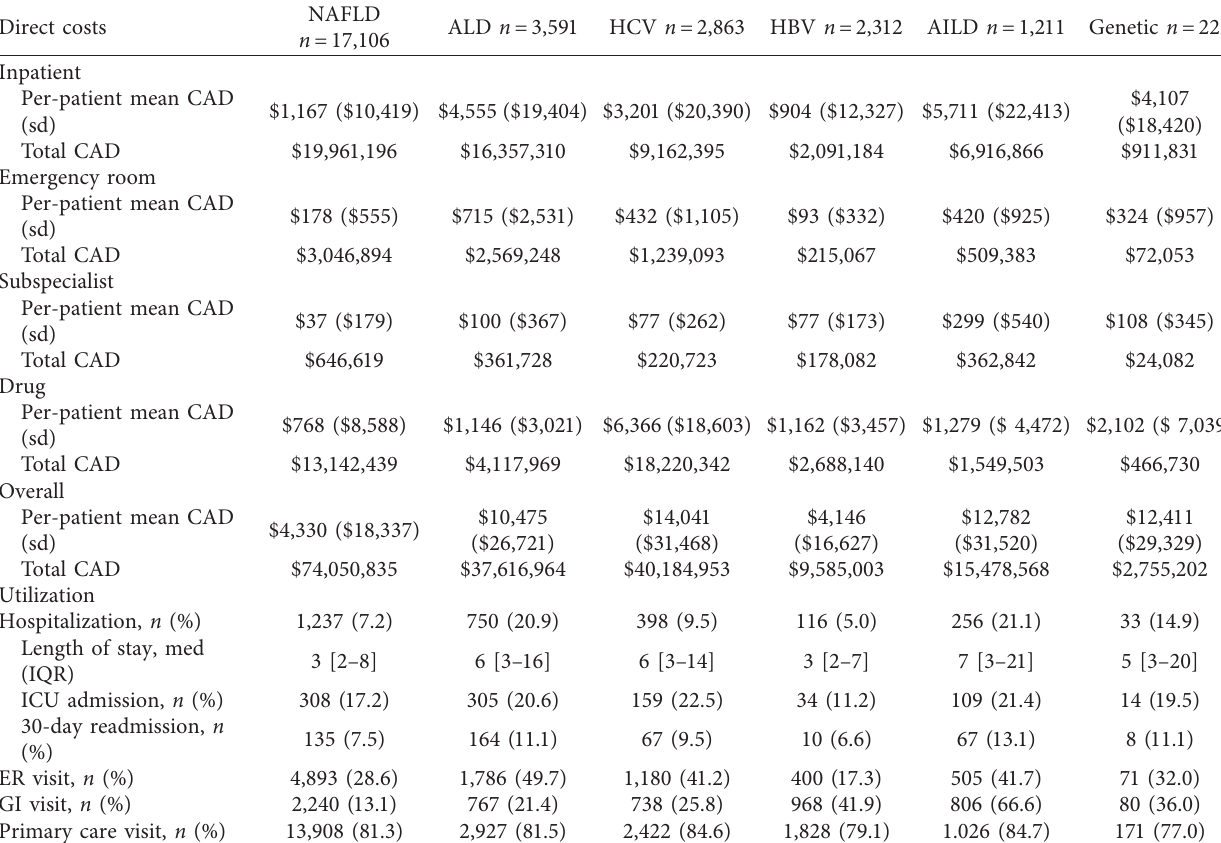
Table 3: Direct healthcare costs and utilization of young adults with cirrhosis in Ontario (2016).